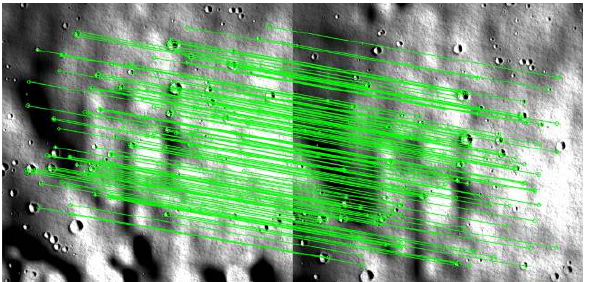
Figure 2. Point extraction, description and matching: correct matched pairs of points in consecutive overlapping images.